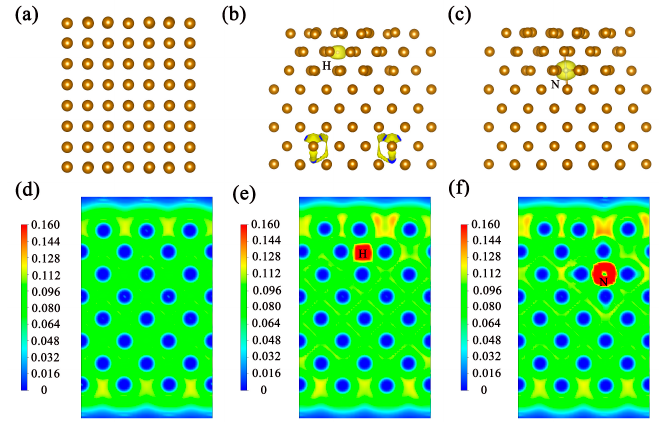
Figure 3. DOS of pure γ -Fe and H/N-containing austenite. ( a – c ) are the 3D ELF of pure γ -Fe and H/N-containing austenite, respectively. ( d – f ) are the 2D ELF of pure γ -Fe and H/N-containing austenite, respectively.